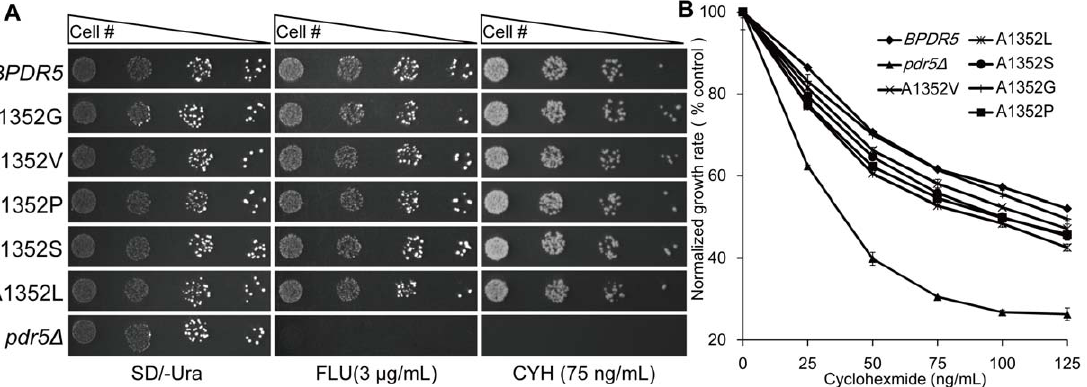
Figure 4. Drug resistance profiles of pdr5 D S.cerevisiae cells expressing wild type and A1352 mutant variants of PDR5 on agar plates and in liquid culture. (A) Drug sensitivity of A1352 mutant variants determined by spot assay. Serial dilutions of BPDR5 cells, pdr5 D and A1352 mutant variants were spotted on SD/-Ura agar plates in the absence (left panel) and the presence (right panel) of 75 ng/mL cycloheximide, respectively. The plates were incubated at 30 u C for 72 hours. (B) Quantitative analysis of drug resistance mediated by Pdr5p mutants. Cells carrying empty plasmid or overexpressing BPDR5 , A1352 mutant variants as indicated, were subjected to analysis in liquid culture as described in materials and methods. OD600 values at 12 h were analyzed. Growth in drug free cultures of each strain was served as control. Normalized growth rates are shown as the means 6 standard deviations (error bars) for three independent experiments at each concentration of cycloheximide.